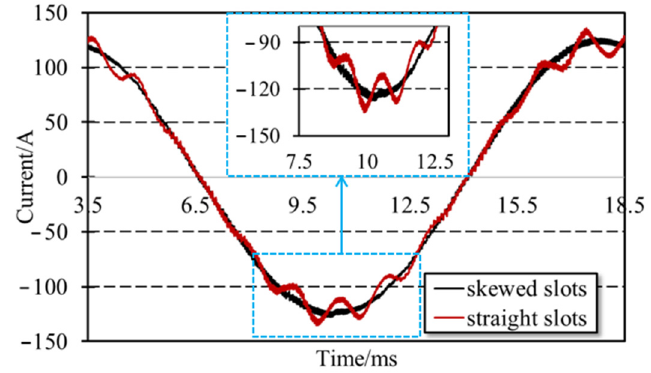
Figure 2. Current waveform at 1000 rpm and rated load.